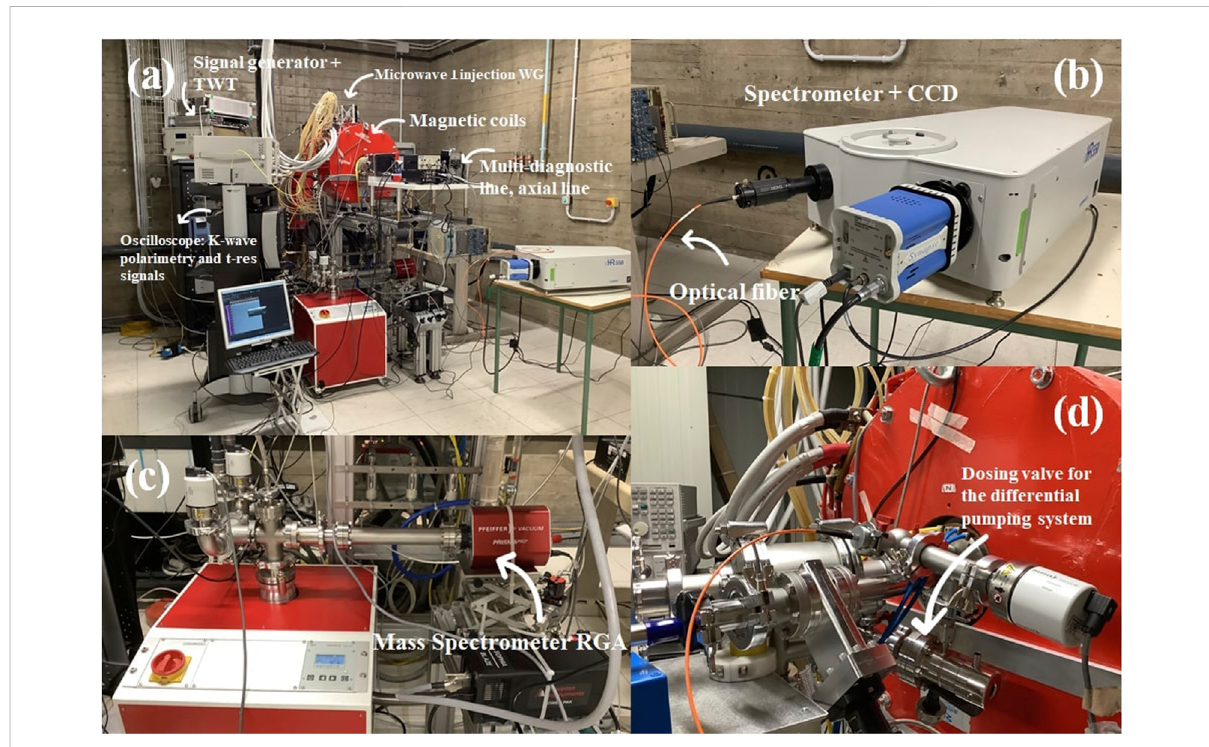
FIGURE 1 FPT experimental room and apparatus. (A) View of the FPT setup, including the chamber, magnetic coils, the RF instrumentation, and the axial diagnostic line. (B) Horiba spectrometer and the CCD detector, connected to the optical fi ber. (C) RGA and the differential pumping system set to perform mass spectroscopy of gases in the chamber. (D) Part of the X-ray diagnostic line, with focus on the ori fi ce to dose gas into the